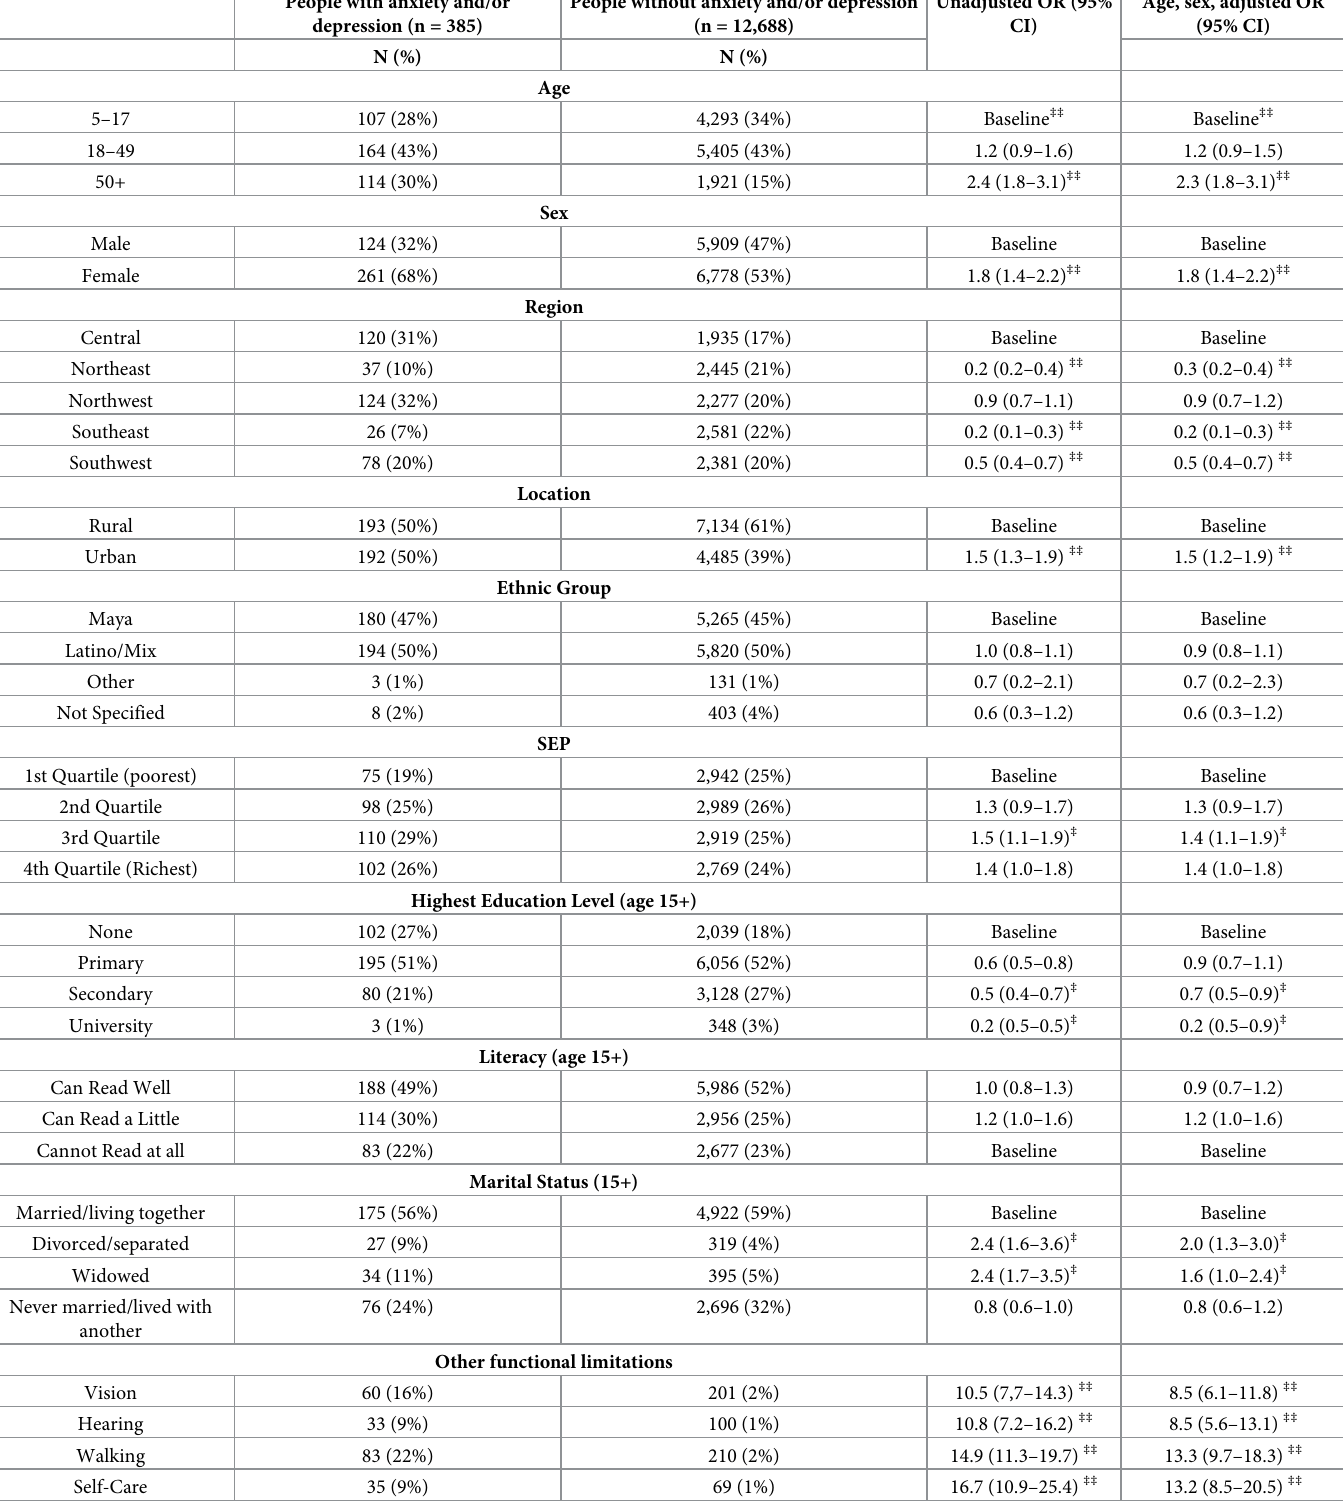
Table 3. Socio-demographic characteristics of people with and without anxiety and/or depression (n = 13,073). People with anxiety and/or depression (n =